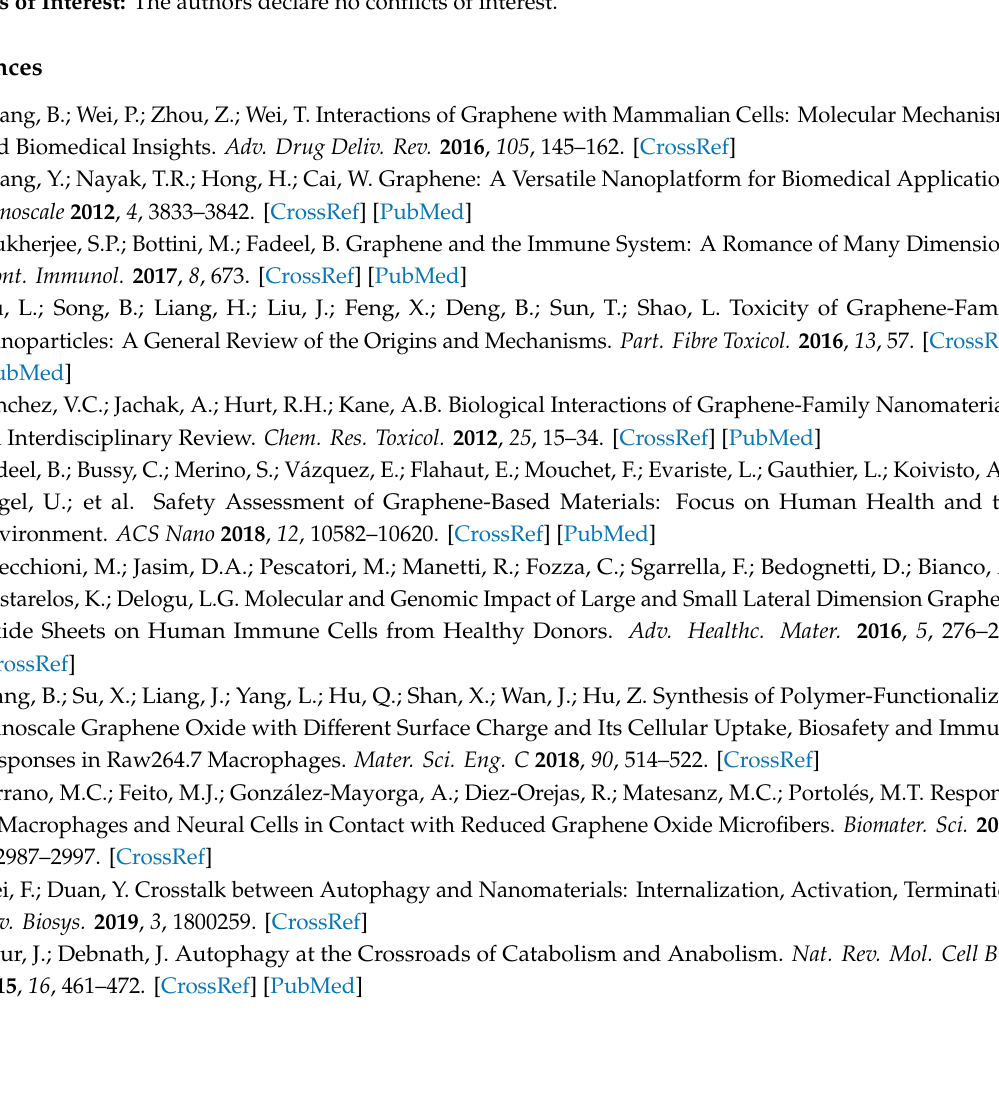
Figure S1. Control experiments for flow cytometry stainings. Control unstained BMDMs are shown in red while DMSO-treated e780-FVD-stained positive cells (Figure S1A) and CD80-FITC-stained positive cells (Figure S1B) are shown in blue. Figure S2. Optical microscopy images of untreated, low (10 µ g / mL) and high (100 µ g / mL) concentration of FLG and LPS (1 µ g / mL)-treated BMDMs for 24 h. Figure S3. Flow cytometry analysis of viability and apoptosis of BMDMs treated with di ff erent concentrations of FLG (3, 10, 30 and 100 µ g / mL), with LPS (1 µ g / mL) and left untreated, for 24 h. (A) Representative dot plots, and (B) corresponding bar graph of percentages of total population of cells showing viable, early apoptotic, late apoptotic and dead population of